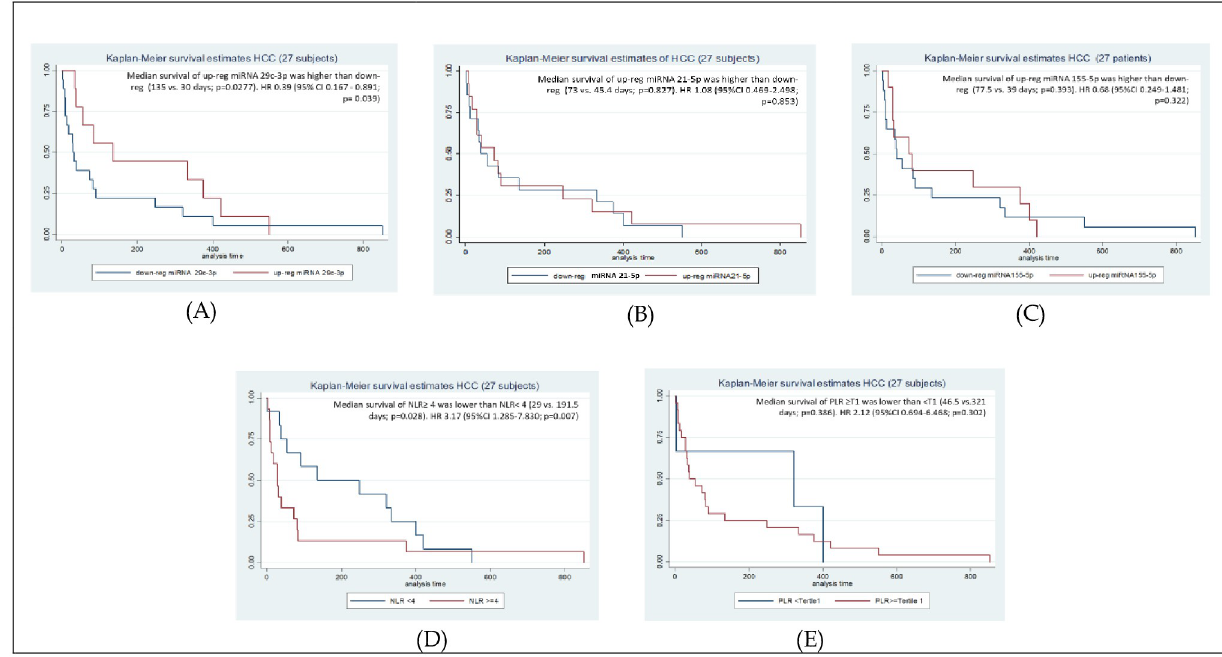
29c-3p correlated with tumor size, multiplicity pathologic features, and shorter the overall sur- vival; and up-regulation of miRNA 29c-3p correlates with inhibition cell proliferation, apopto- sis, migration, and tumor growth in vivo [40]. However, down-regulation of miRNA 29b-3p in blood correlates with tumor suppressor and oncomir only [37].